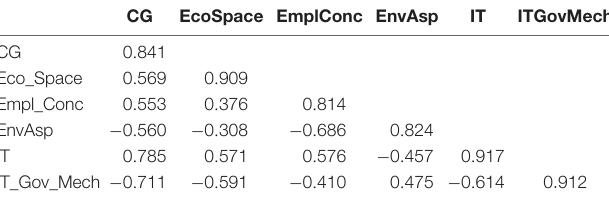
TABLE 5 | Fornell and Larcker